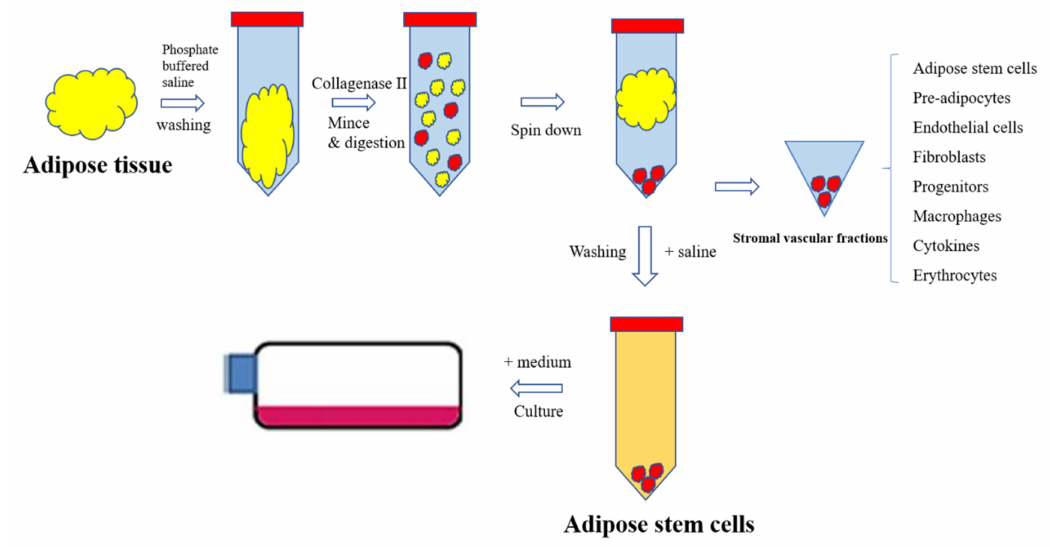
Figure 3. Enzymatic processes in isolation of adipose stem cells.